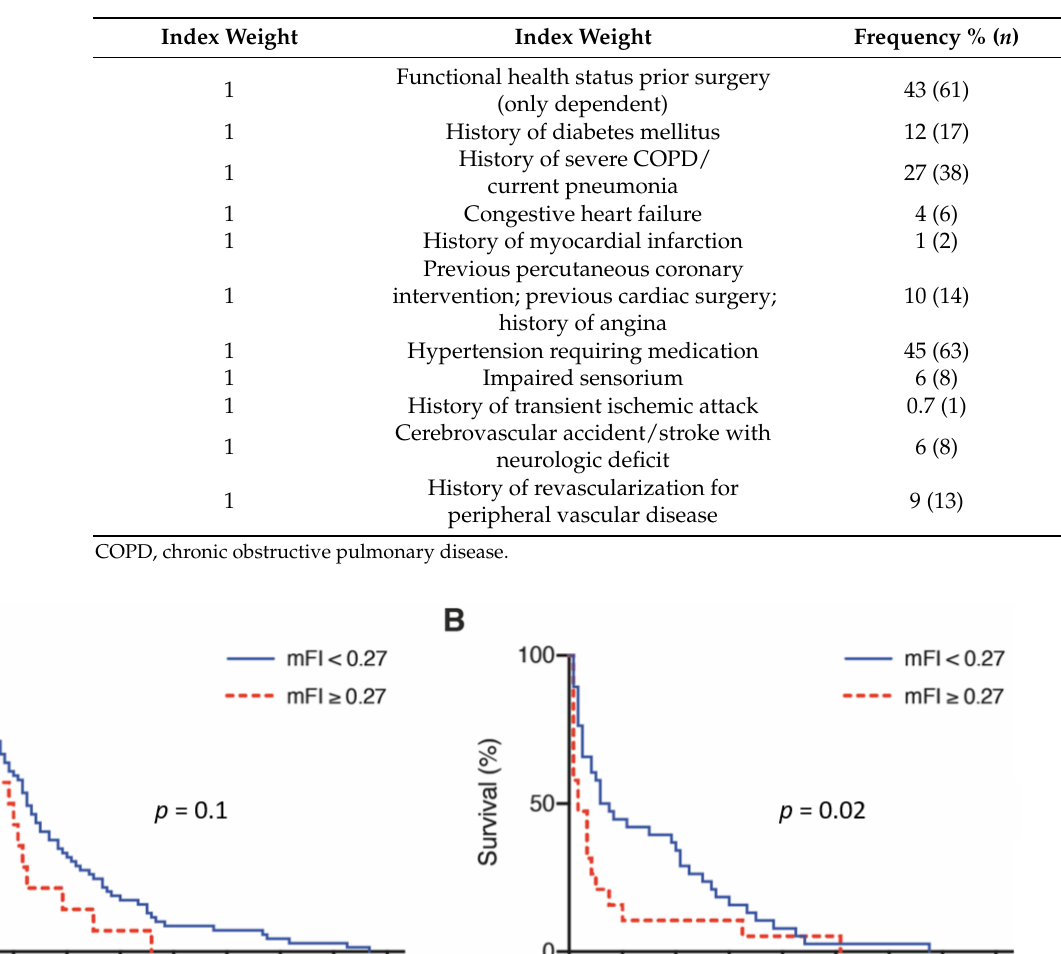
Table 2. Frequency of Patient Frailty According to the Modified Frailty Index.